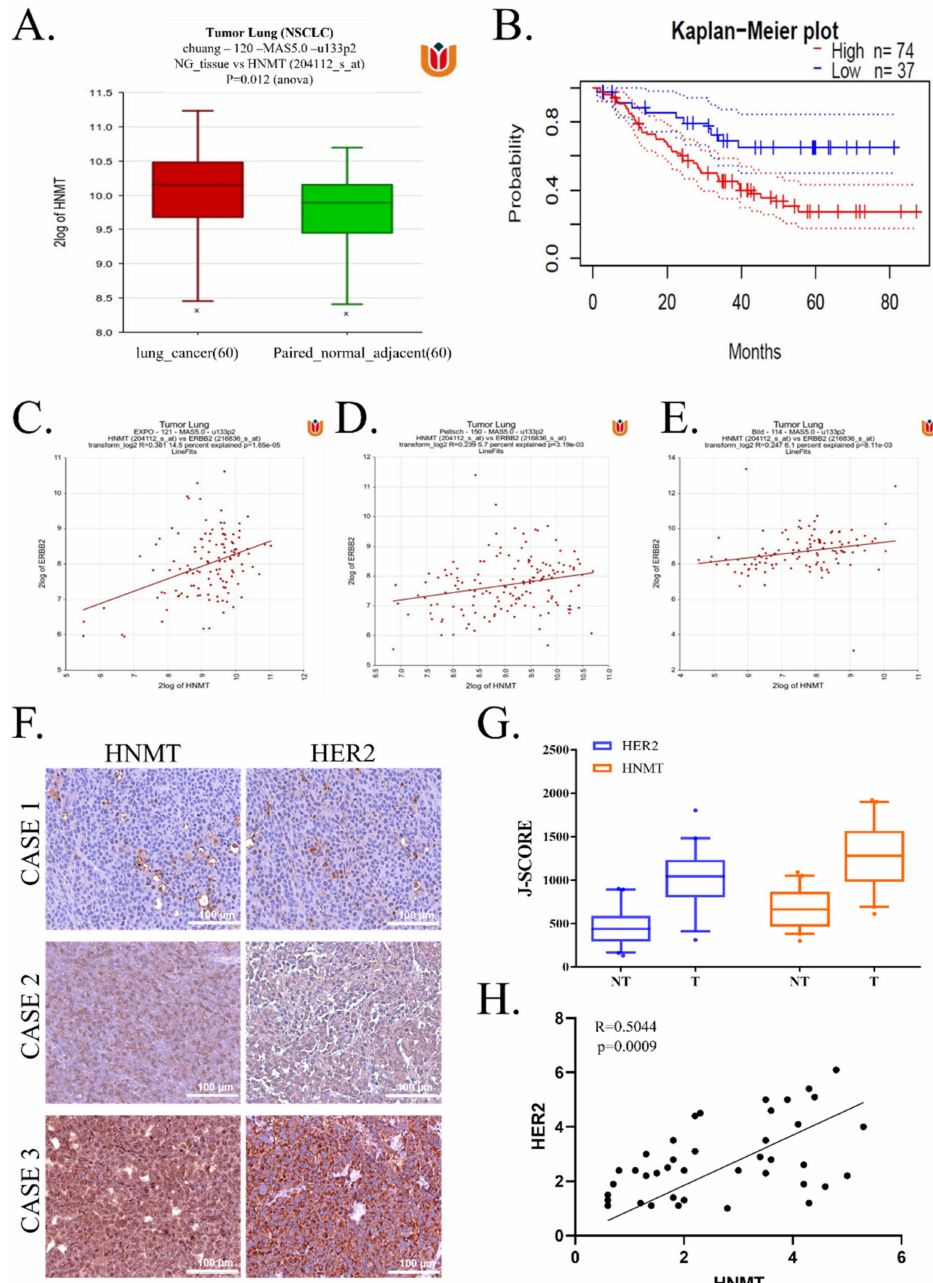
Figure 1. Association of HNMT with worse prognosis in NSCLC and its correlation with HER2 expression. ( A ) HNMT mRNA expression was evaluated using RT-qPCR. Samples were grouped as NSCLC and paired with normal adjacent. ( B ) Kaplan–Meier survival analysis of patients with NSCLC expressing HNMT based on the Prognoscan database (GSE3141). HNMT and HER2 (ERBB2) gene correlation analysis determined using R2: Genomics Analysis and Visualization Platform (http://r2.amc.nl; accessed on 21 November 2021) from the dataset ( C ) Peitsch ( n = 121), ( D ) EXPO ( n = 150), and ( E ) Bild ( n = 114). ( F ) Representative immunohistochemistry staining from three NSCLC cases. ( G ) J-score comparison between nontumor and tumor tissues taken from NSCLC clinical tissue samples. ( H ) HNMT and HER2 protein expression correlation analysis in NSCLC clinical tissue samples. Scale bar: 100 µ